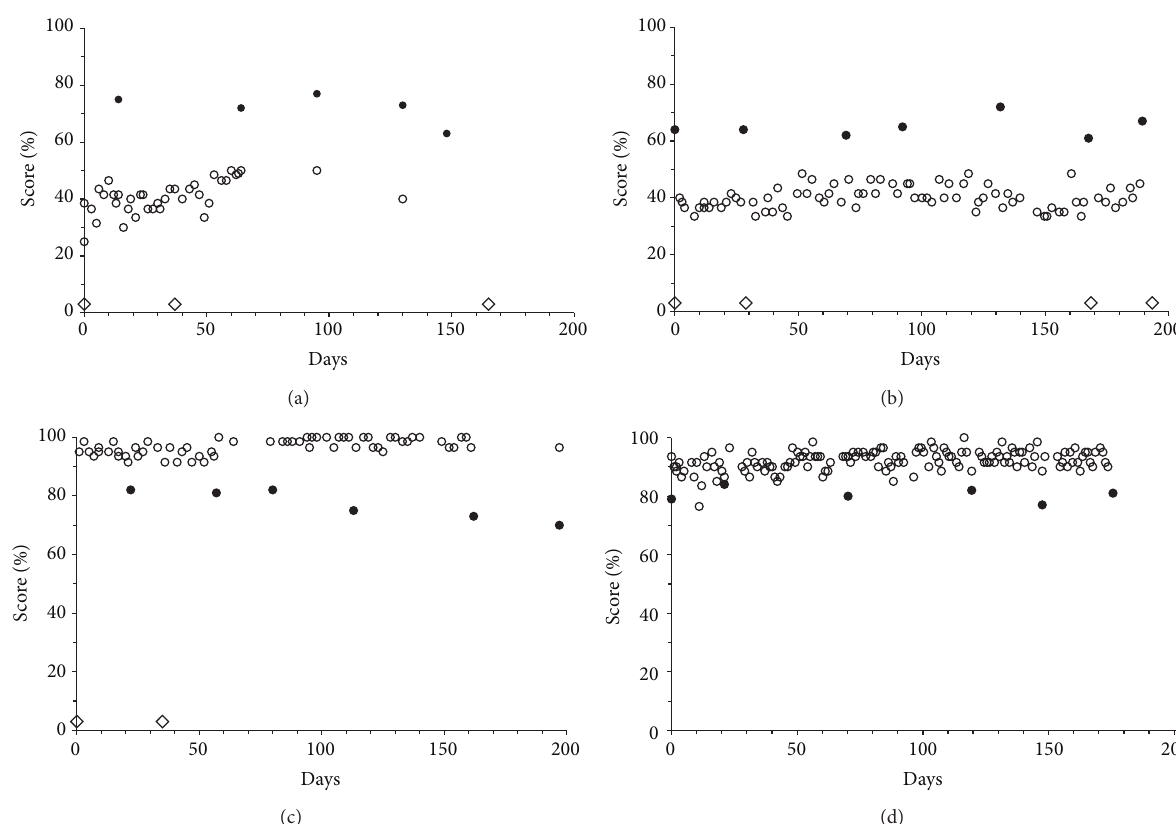
Figure 4: Sequential MBT ( l ) and ETDRS ( ∙ ) results from 3 patients with wet AMD and 1 with dry AMD (d). Diamonds ( ⬦ ) identify times of treatment.